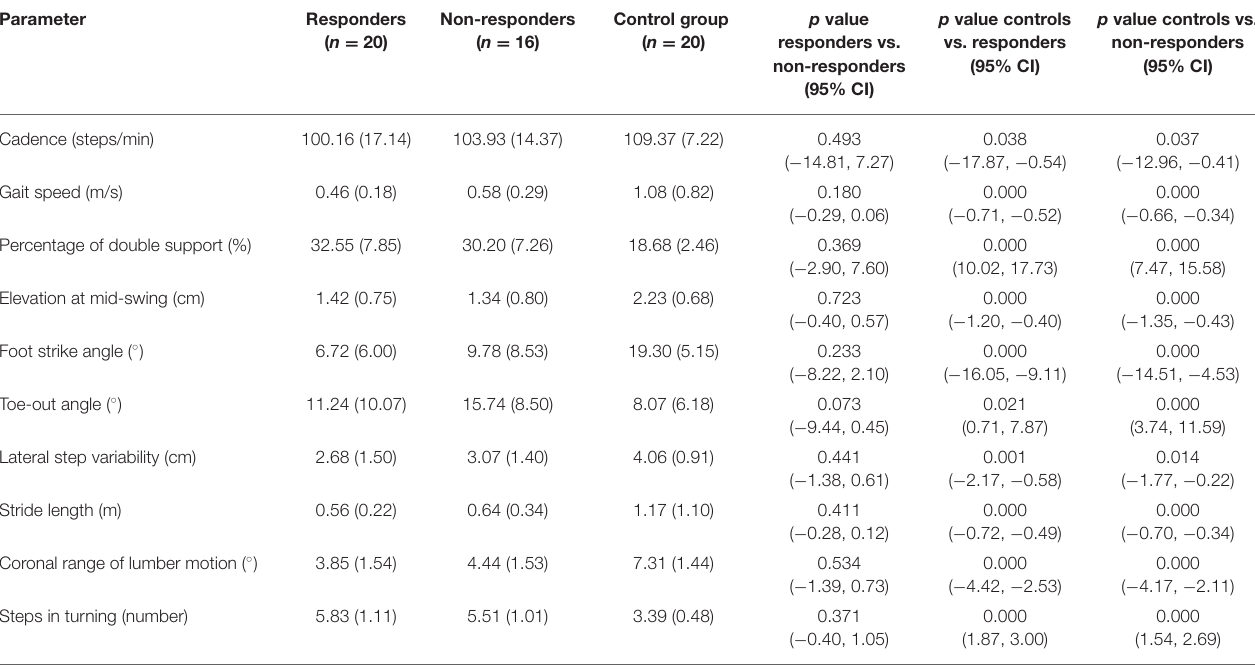
TABLE 2 | Mean values of gait parameters before